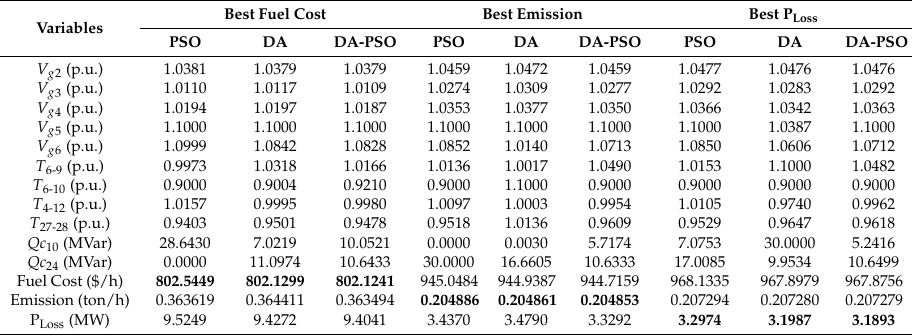
Variables V g 2 (p.u.)